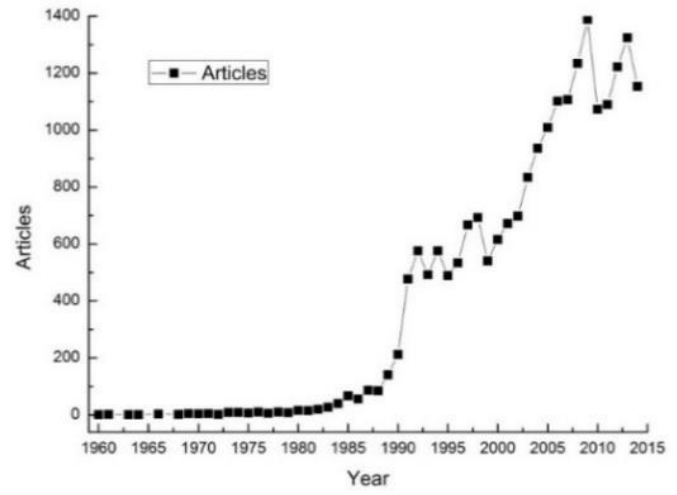
Figure 1. Growth trend of articles in artificial intelligence from 1990–2014.